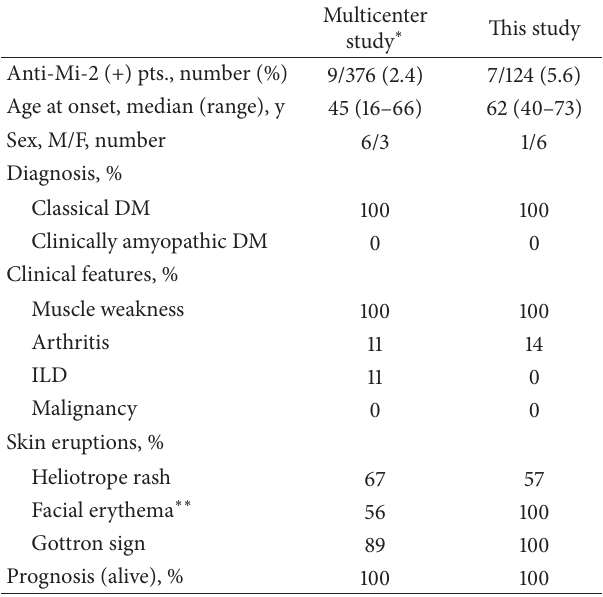
Table 1: Comparison of clinical data for patients with anti-Mi-2 antibody in a previous report and in the present study.